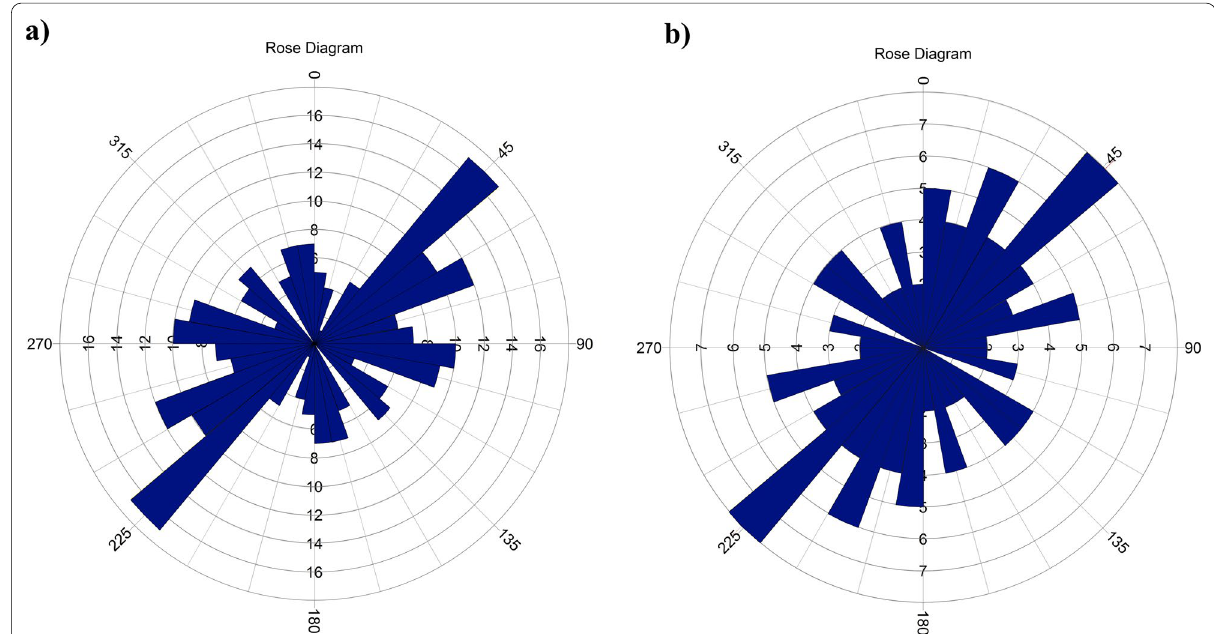
Fig. 12 Rose diagram of lineaments revealed by this work for: a gravity lineaments and b magnetic